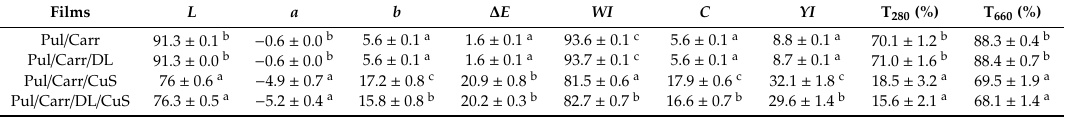
Table 1. Surface color and transmittance of pullulan / carrageenan-based composite films. Films L a b ∆ E WI C YI T 280 (%) T 660